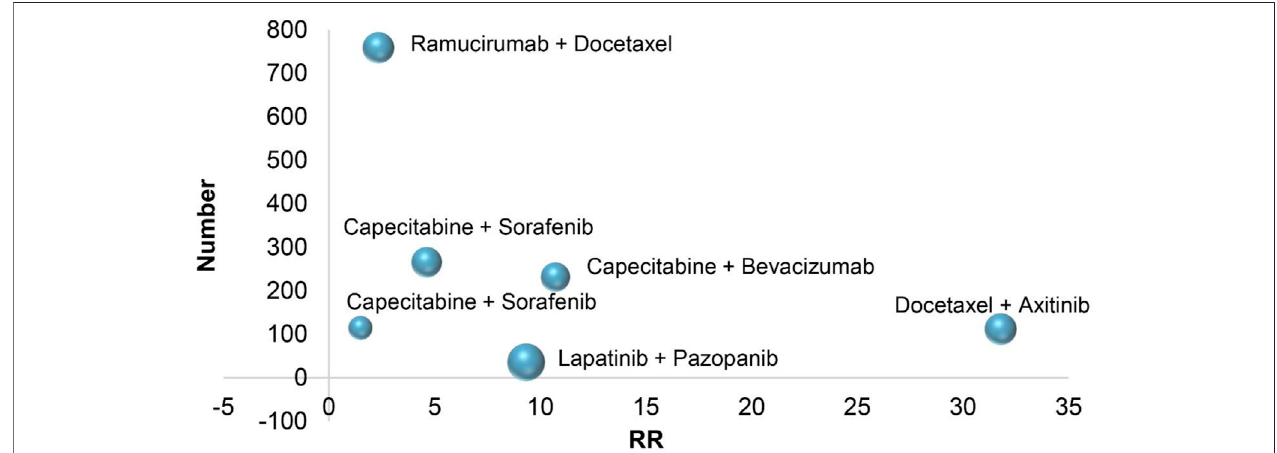
FIGURE 3 | Bubble chart: Breast cancer treatment.